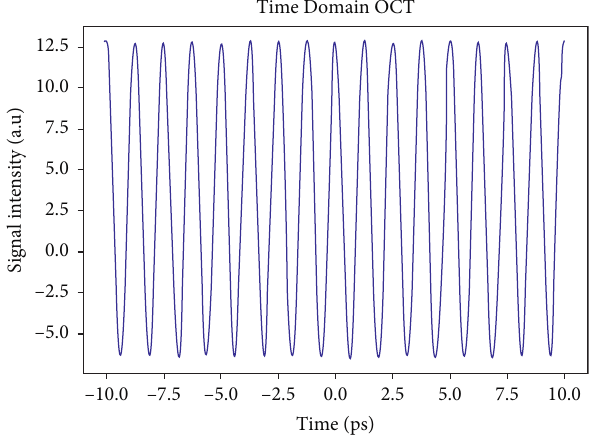
Figure 6: Signal intensity of monochromatic sources.